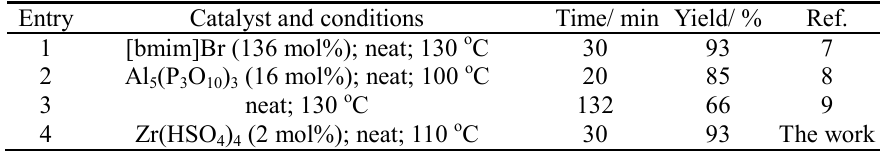
Table 3 . Zr(HSO ) -catalyzed synthesis of 3-(2′-benzothiazolyl)-2,3-dihydro-2-(phenyl)- 4 4 quinazolin-4(1 H )-one in comparison with other